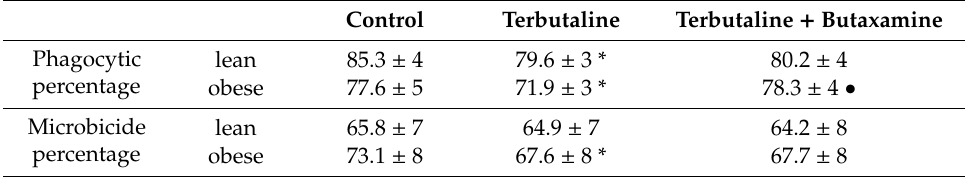
Each value represents the mean ± SEM of independent assays performed in duplicate. * p < 0.05 with respect to the corresponding control value, in the absence of terbutaline and butaxamine; • p < 0.05 with respect to the corresponding terbutaline value.